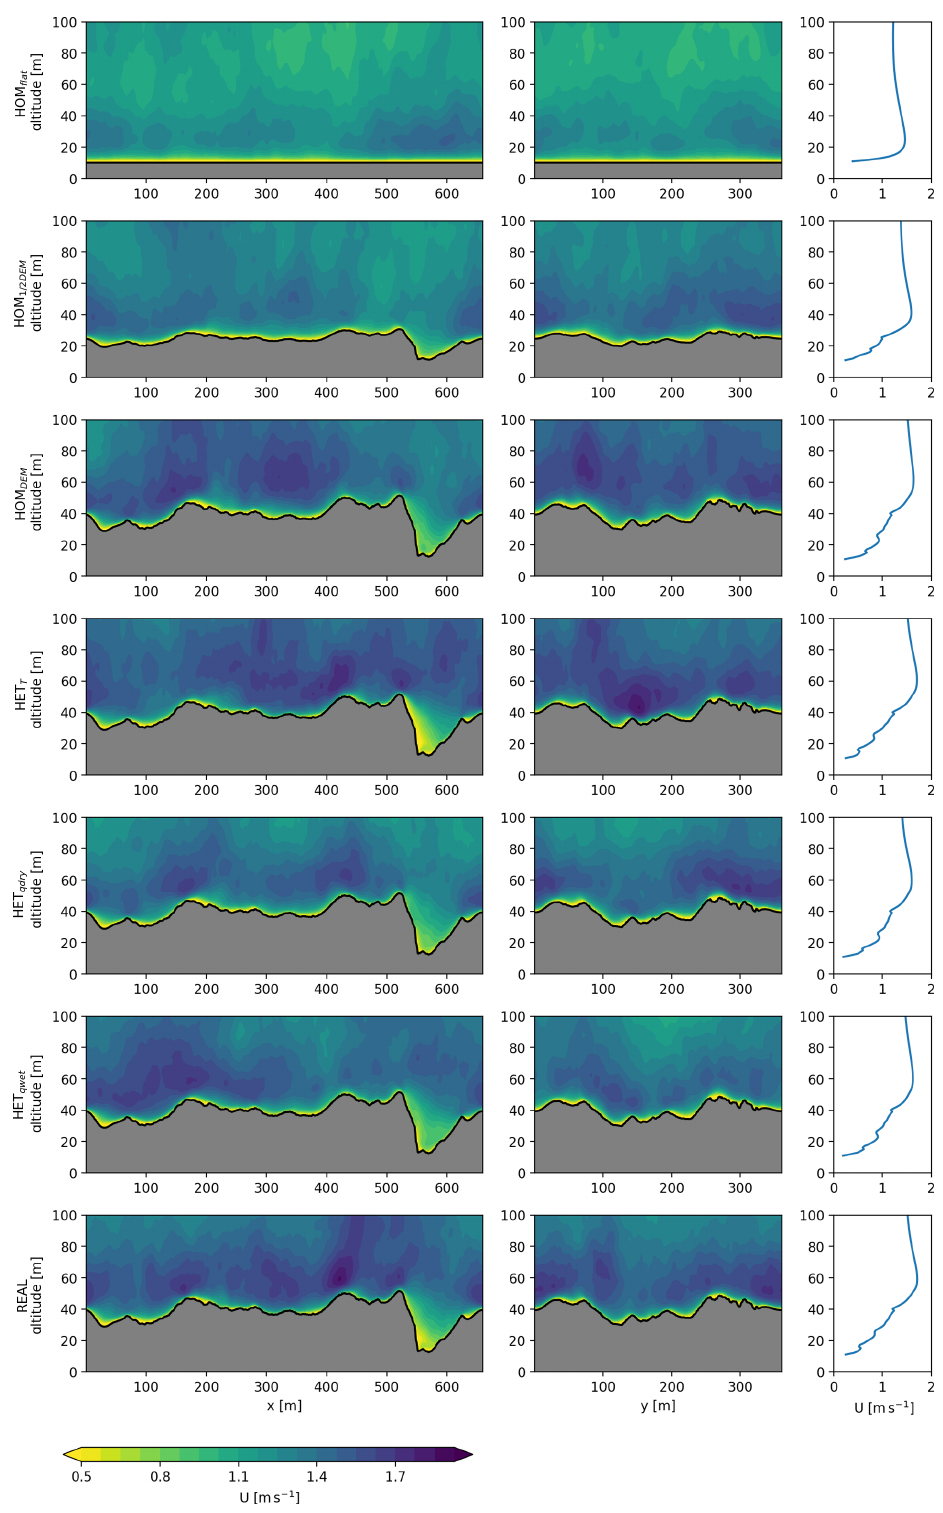
Figure 5. Cross sections (left and middle columns) and average vertical profile (right columns) of the wind speed for all experiments presented in the same order as in Table 1. The location of the cross sections is shown in Fig.